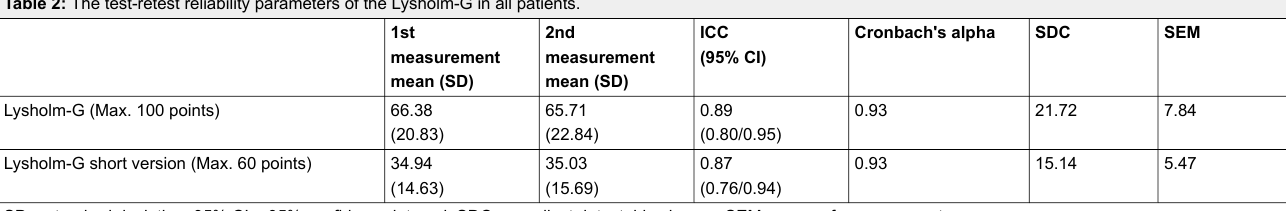
Table 2: The test-retest reliability parameters of the Lysholm-G in all patients.